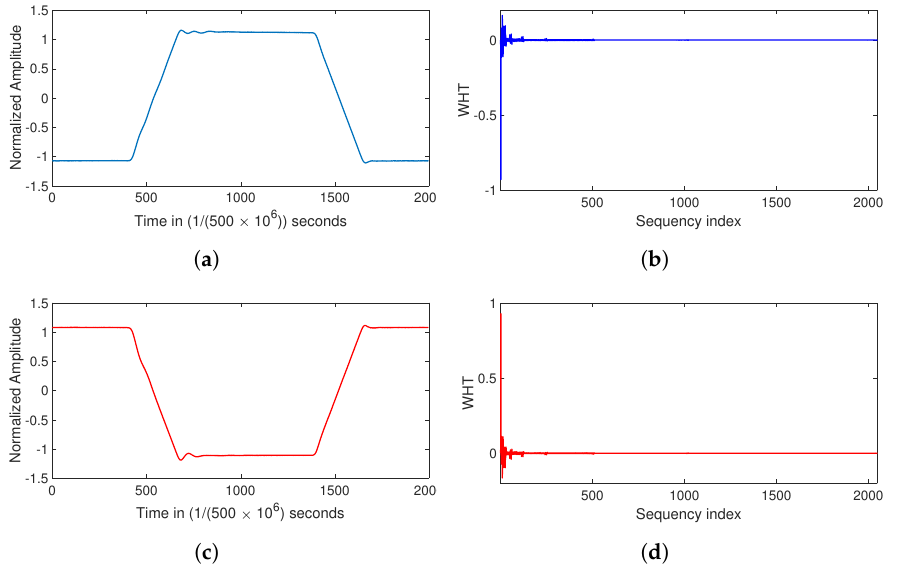
Figure 2. Examples of the Voltage A and Voltage B signals, and their WHT transforms. ( a ) Example of CANH-Voltage A. ( b ) WHT Voltage A. ( c ) Example of CANL-Voltage B. ( d ) WHT Voltage